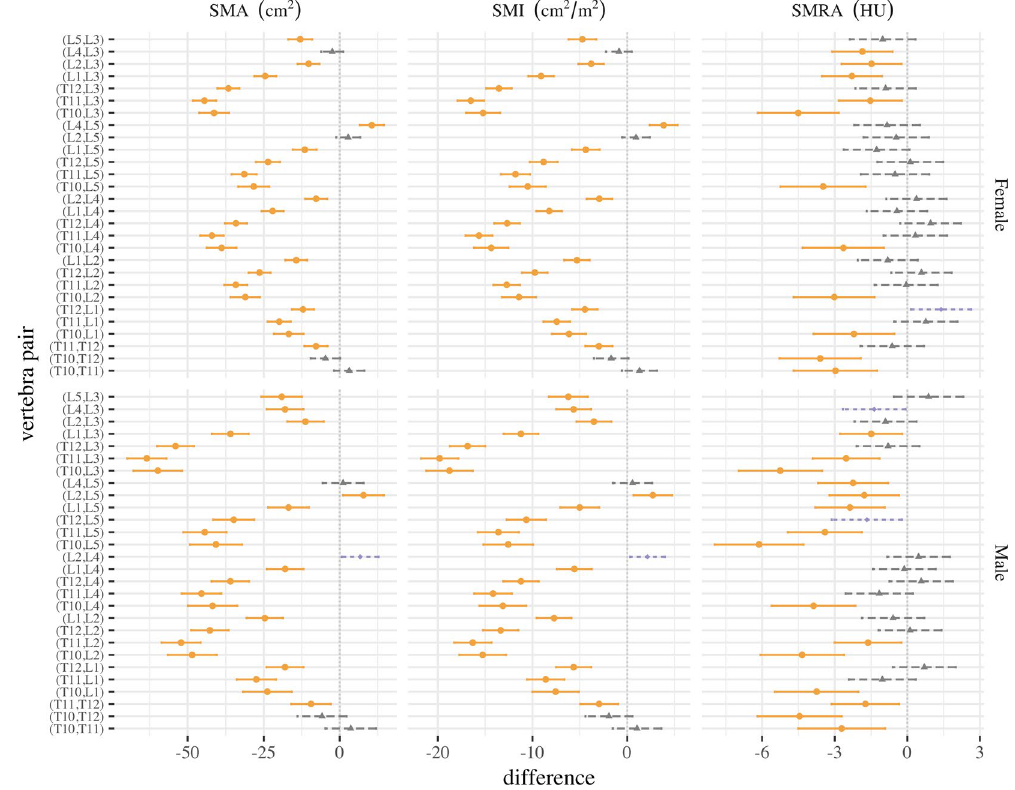
Figure 2. Tukey mean difference and 95% confidence interval for SMA, SMI, and SMRA at each vertebral level pair, by sex. Differences with p < 0.01 (orange circles), p < 0.05 (purple diamonds), and p > 0.05 (grey triangles) are